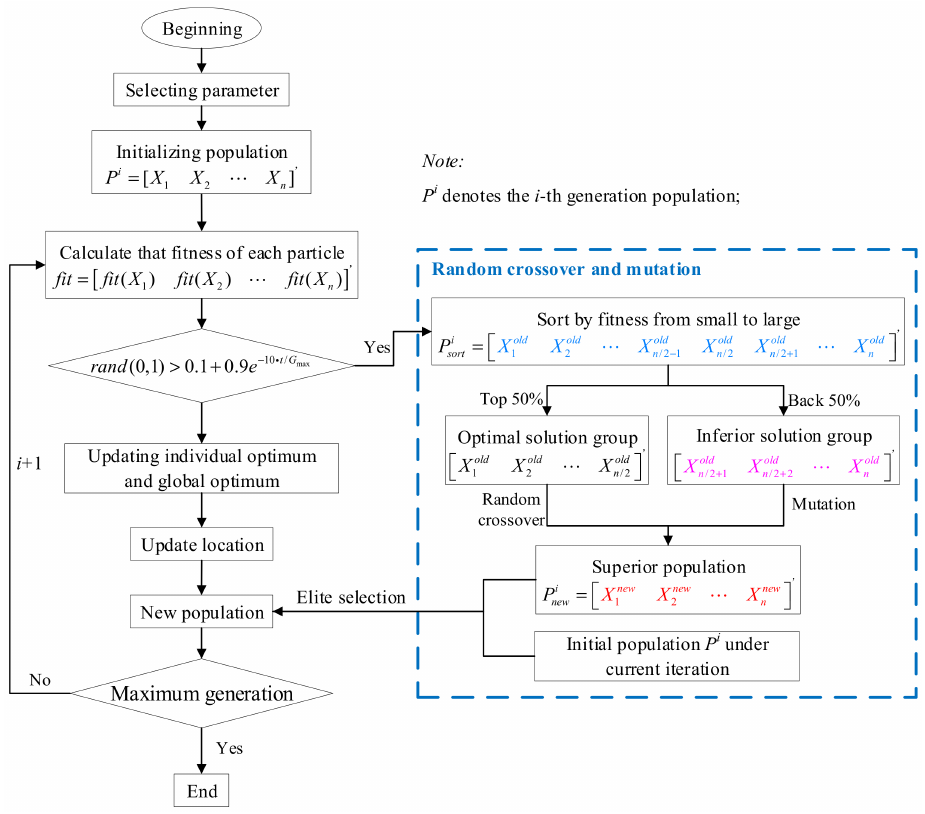
Figure 1. Flow chart of the improved